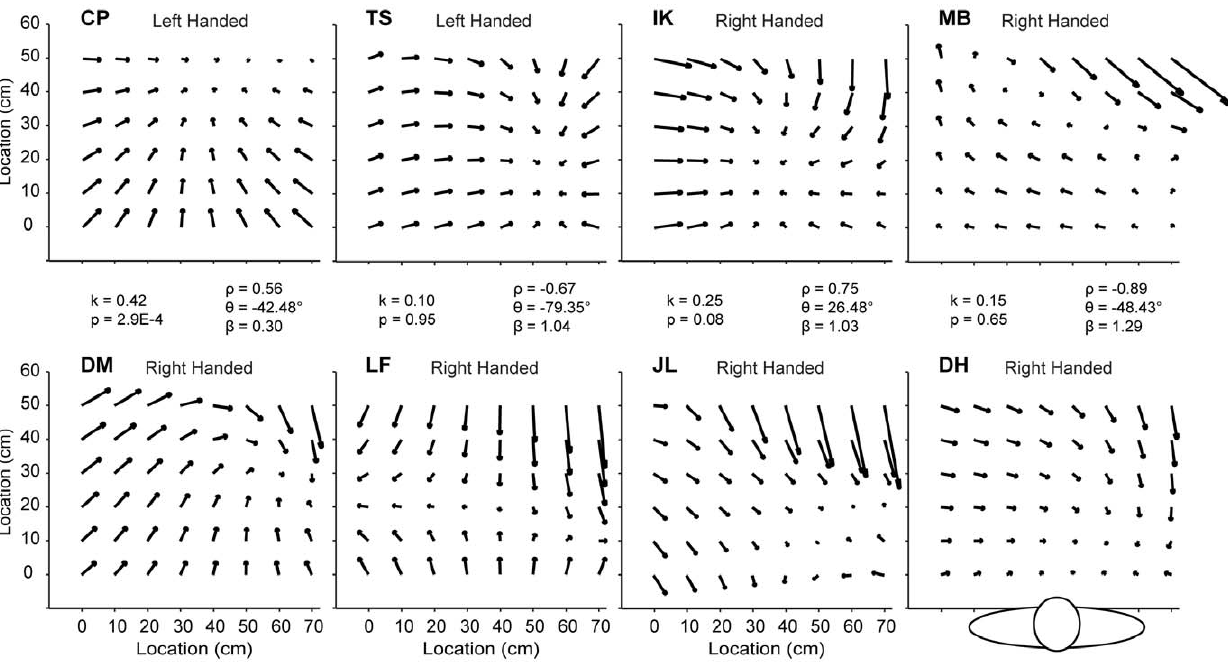
Figure 2. Idiosyncrasy of Pattern of Errors Across Subjects. Distribution of errors from six right-handed and two left-handed subjects when using the Right hand in the Touch condition. Each arrow represents the constant error predicted by the fourth-order regression. The human figure represents the location of a subject with respect to the grid and the resulting pattern of errors. The text in the middle of the figure represents the resulting values from the K-S test and vector correlation analysis for the comparison between the adjacent (above and below) two vector fields.